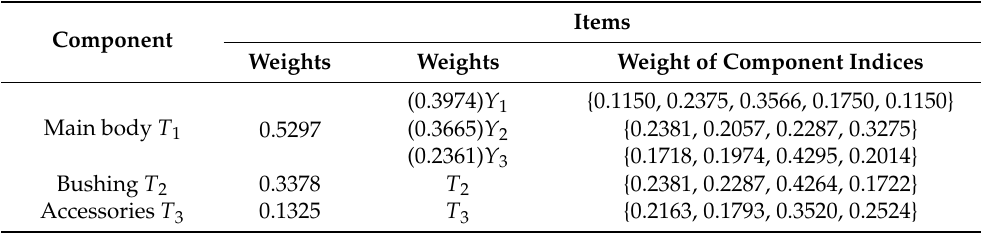
Table 3. Weights of assessing